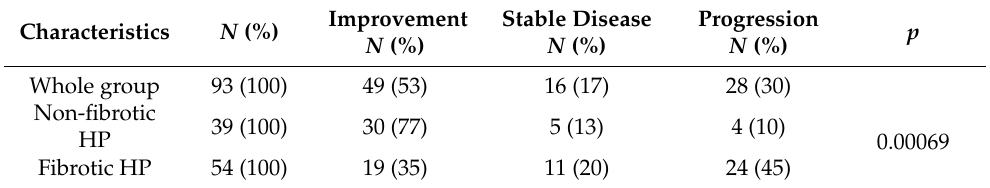
Table 3. Treatment response according to the presence of fibrosis in HRCT.